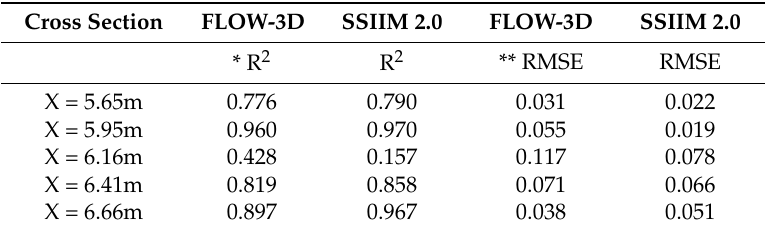
Figure 4. Scouring-time chart.